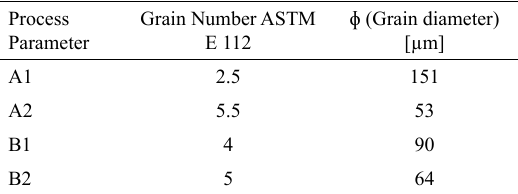
Table 4. Average grain sizes of α phase (95% of